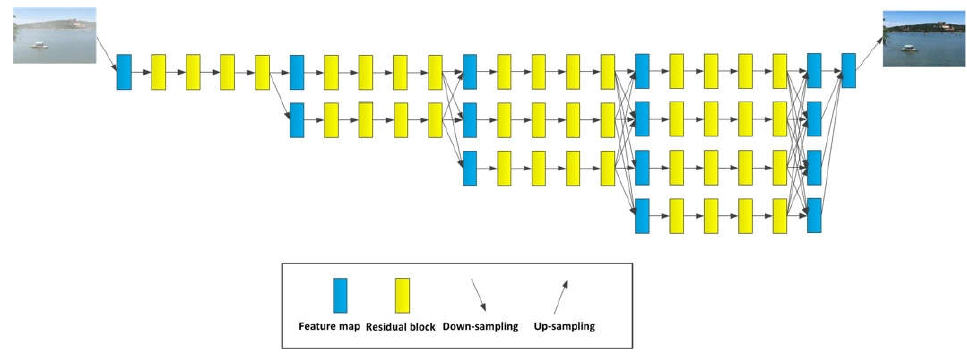
Figure 2. The architecture of the DeHRNet. Parallel connection between different branches to ensure the same resolution.